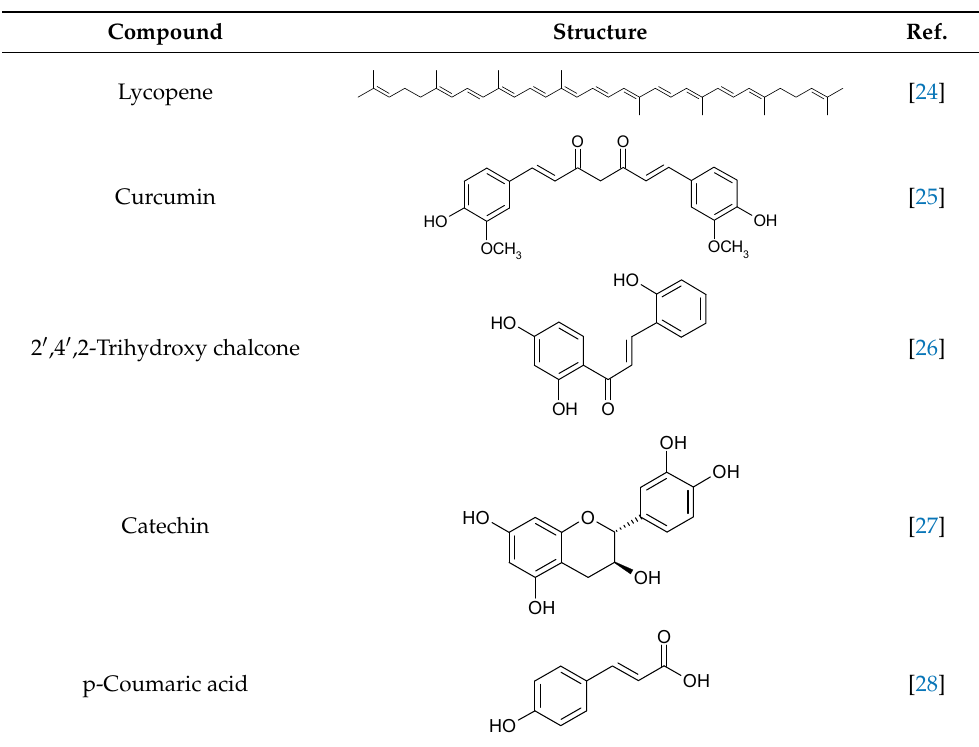
Table 2. Structures of some phytochemicals with documented cardioprotective potential.